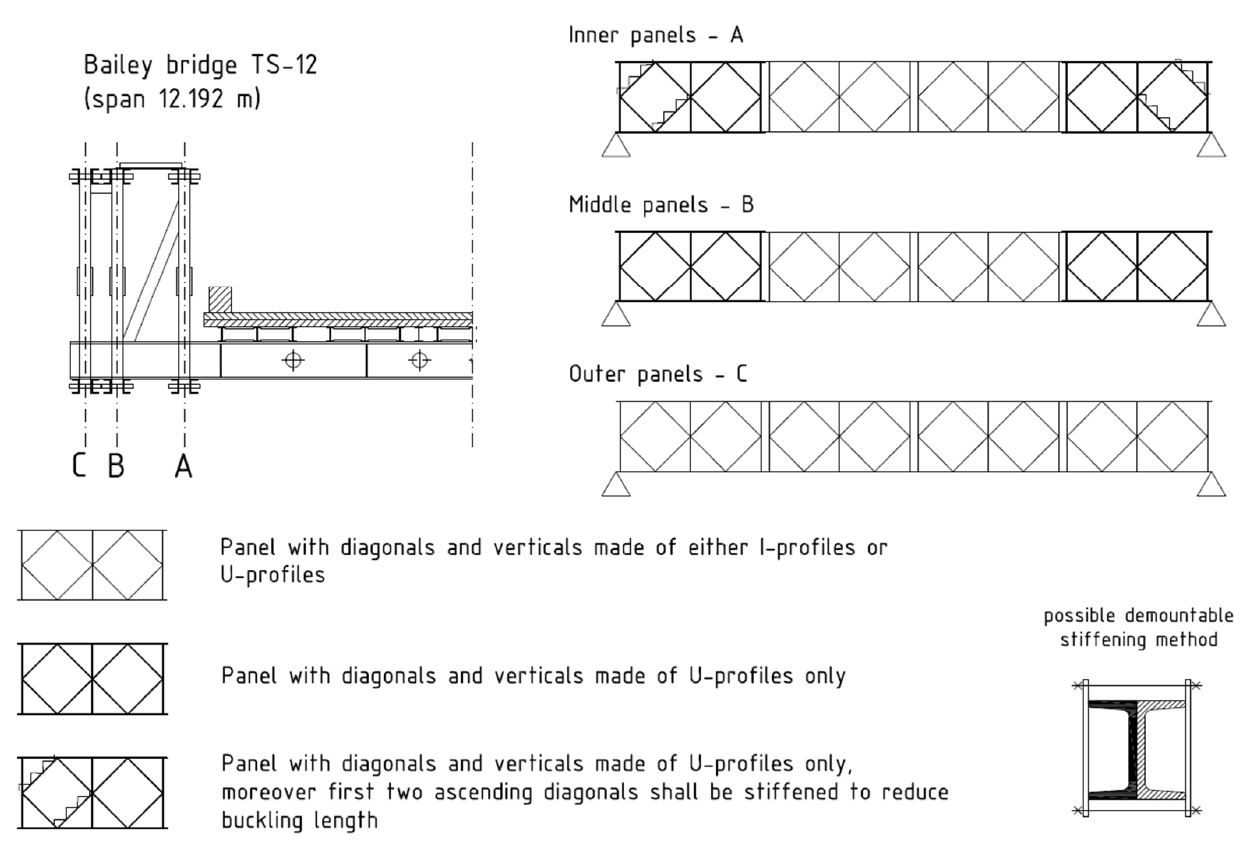
Figure 16. Example of enhancement of load ‐ carrying capacity by arrangement of panels.